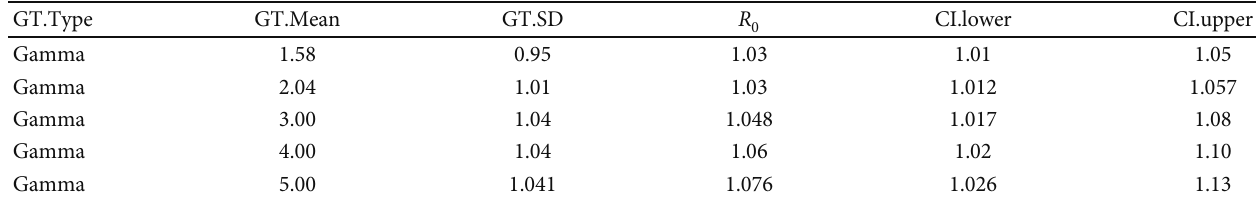
Figure 4: Sensitivity analysis of e ff ective basic reproduction number and generation time (GT) using exponential growth (EG) estimate. Table 2: Estimation of the initial reproductive number using exponential growth method and the variation in generation time (GT) from the initial day to the eighty-eighth